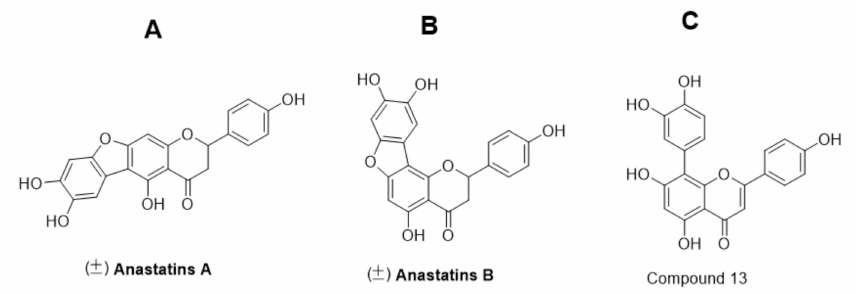
Figure 2. ( A ) Chemical structures of ( ± ) anastatins A, ( B ) ( ± ) anastatins B, and ( C ) compound 13